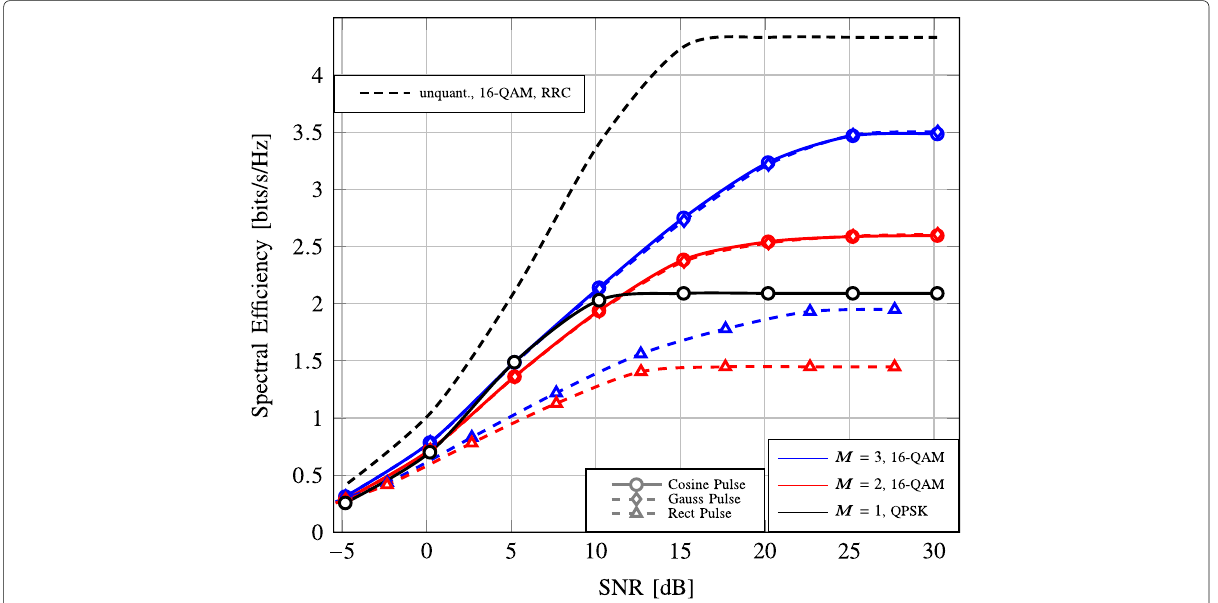
Fig. 7 The spectral efficiency w.r.t. B 90% for different transmit